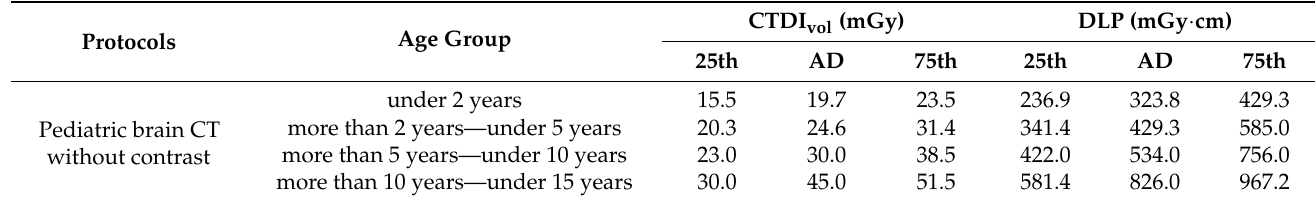
Table 4. 25th and 75th percentile DRLs and Ads of CTDI vol and DLP values of age groups for pediatric brain CT without contrast examinations.